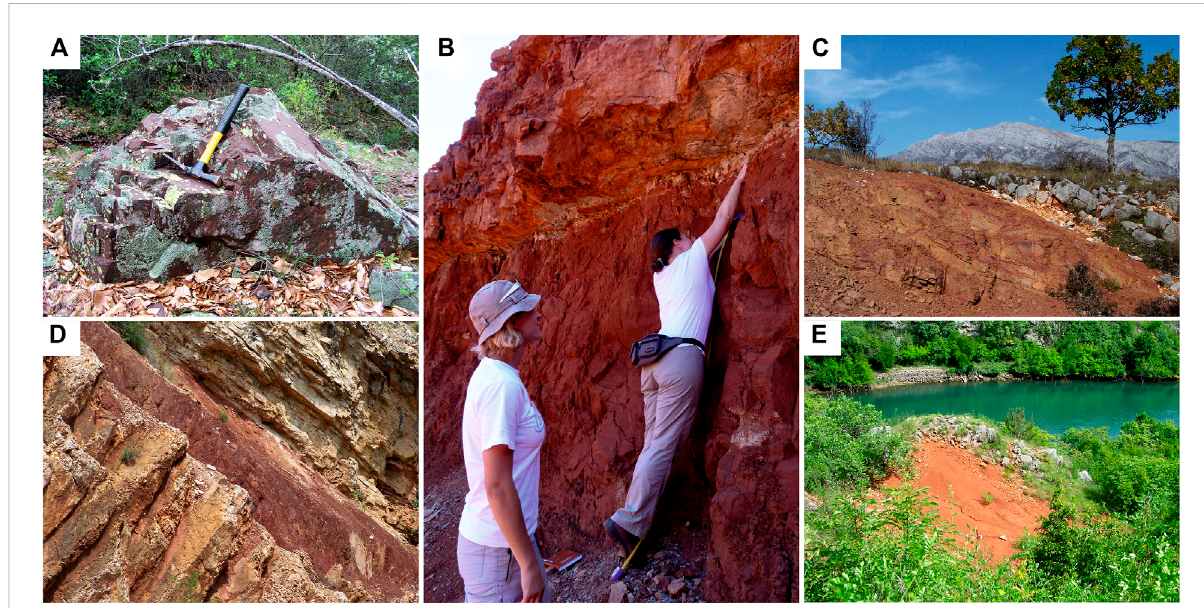
FIGURE 3 Fieldphotographsofthetypicalbauxite-bearinghorizons: (A) UpperTriassicbauxite(BX1)fromVracedepositintheregionofLika. (B) .Sampling of the active Mondelako bauxite deposit near Rovinj (Istria), Upper Jurassic (Malmian) (BX2). (C) Outcrop of a typical small Lower Cretaceous bauxite deposit(BX3).DinaraMt.isinthebackground. (D) BauxiteattheUpperCretaceous(foraminiferallimestone) – UpperEocene( “ Prominabeds “ )contact intheNorthernDalmatia(BX7).Underlyinglimestonebedsshowintensekarsti fi cation. (E) SmalloutcropofMiocenebauxite(BX8)atthebankof the Cetina River (Central